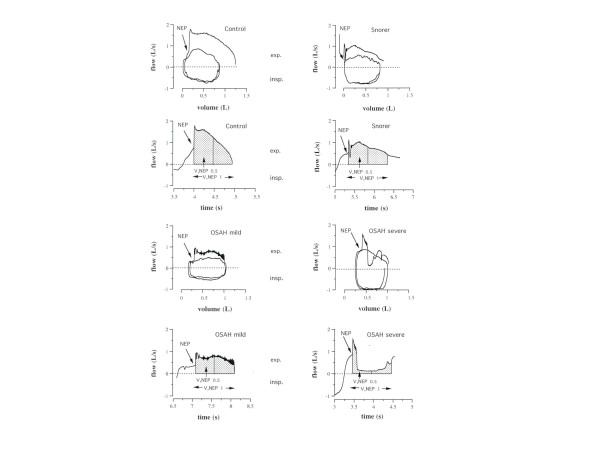
Supine tidal flow-volume curves (control and during NEP of -5 cmH2O) and  corresponding expiratory flow-time curves (only during NEP) in  representative subjects of the different groups. The hatched areas under the  flow measure the volume exhaled in the first 0.5 sec. (V,NEP0.5) and 1 sec.  (V,NEP1) after NEP application.